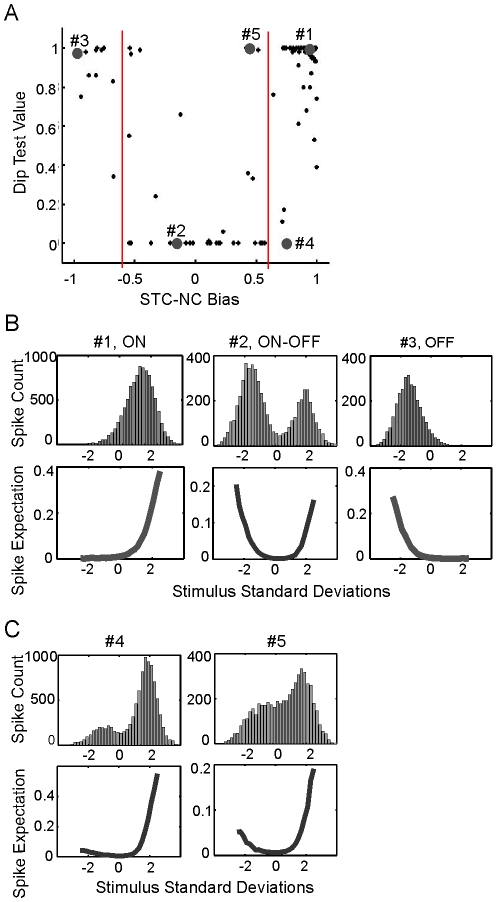
Spiking in response to both positive and negative contrasts (ON-OFF behavior) produces bimodal distributions and symmetric nonlinearities, while ON or OFF cells produce unimodal distributions and asymmetric nonlinearities.(A) Scatter plot of the STC-NC bias against the p value for the null hypothesis of a unimodal distribution. Bimodality was measured using the Hartigan and Hartigan Dip Test. Red lines at −0.6 and 0.6 show the cutoffs for ON and OFF classification. (B–C) The majority of ON and OFF cells were unimodal (e.g., B#1 and B#3) with highly asymmetric static nonlinearities, however, a few demonstrated highly unbalanced bimodality (C#4). Most ON-OFF cells were bimodal with a symmetric static nonlinearity (B#2), though some possessed less symmetric nonlinearities and were not bimodal (C#5).